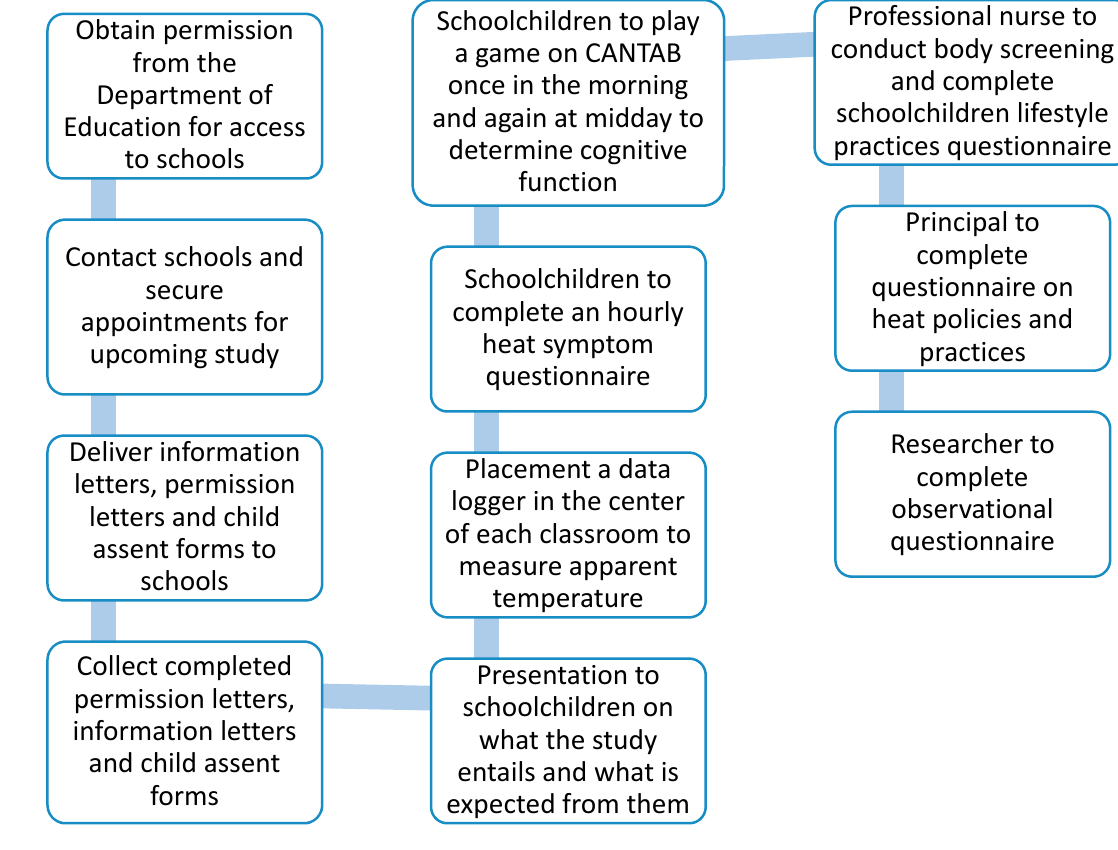
Figure 2. Study Figure 2. Study flowchart.